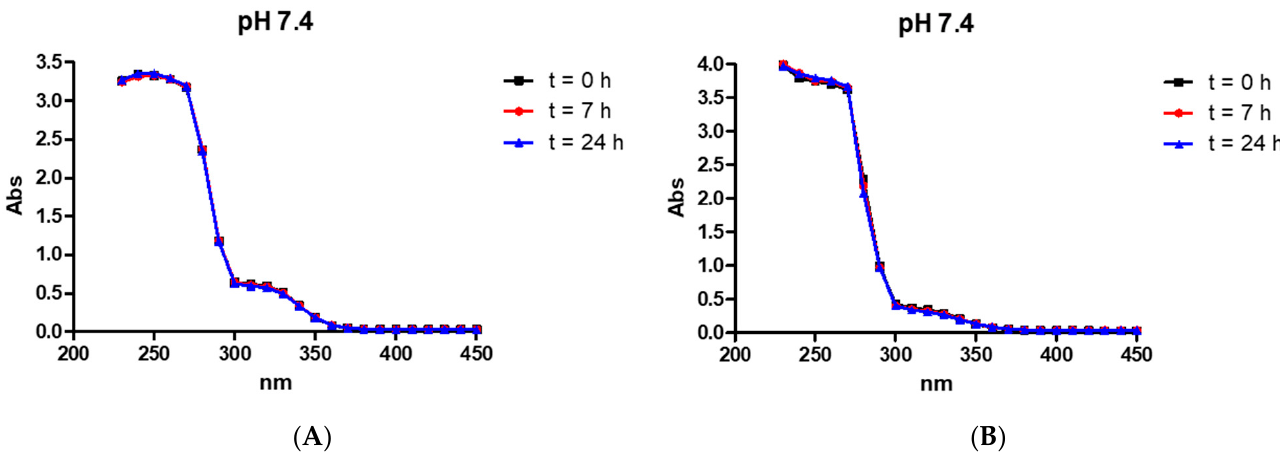
Figure 3. Time-dependent UV-Vis absorption spectra of compound L1 ( A ) and L1Pt ( B ) in PBS solution recorded after t = 0 h (black line), t = 7 h (red line), and t = 24 h (blue line). Table 3. Predicted binding energies of L1 , L1Pt , and BTA on different DNA structures. Docking Binding Energy